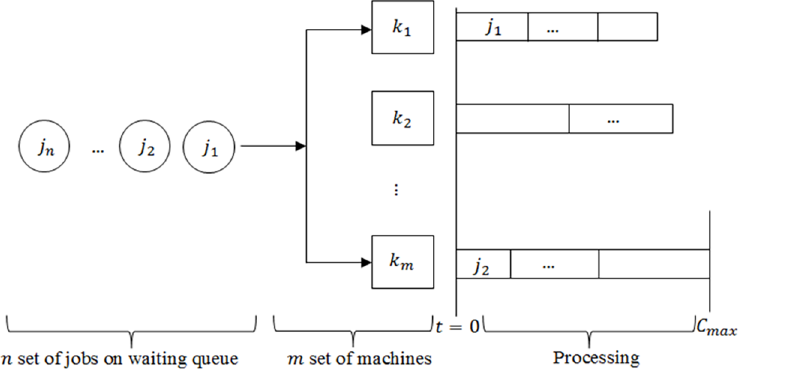
Fig 1. Parallel machine scheduling problem